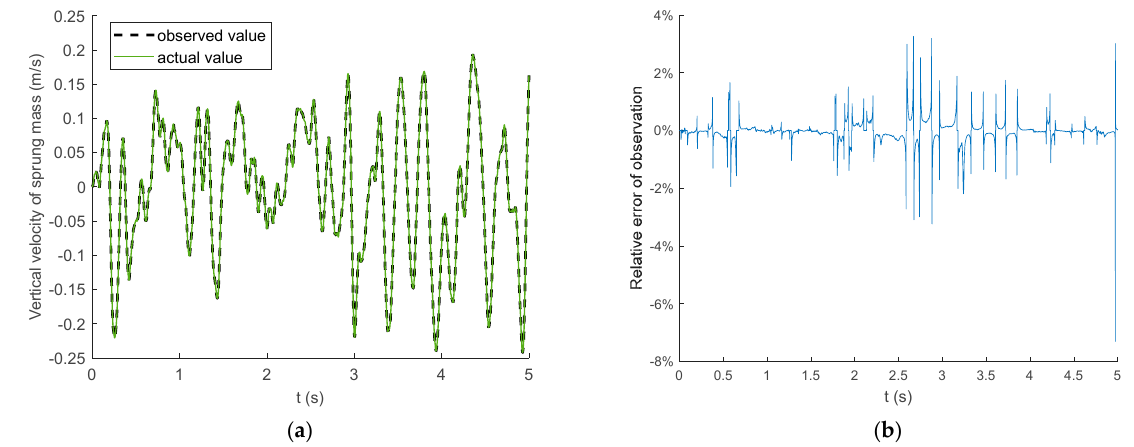
Figure 12. Observed results of vertical velocity of the sprung mass. ( a ) Comparison of observed and actual values. ( b ) Relative error between observed and actual values.